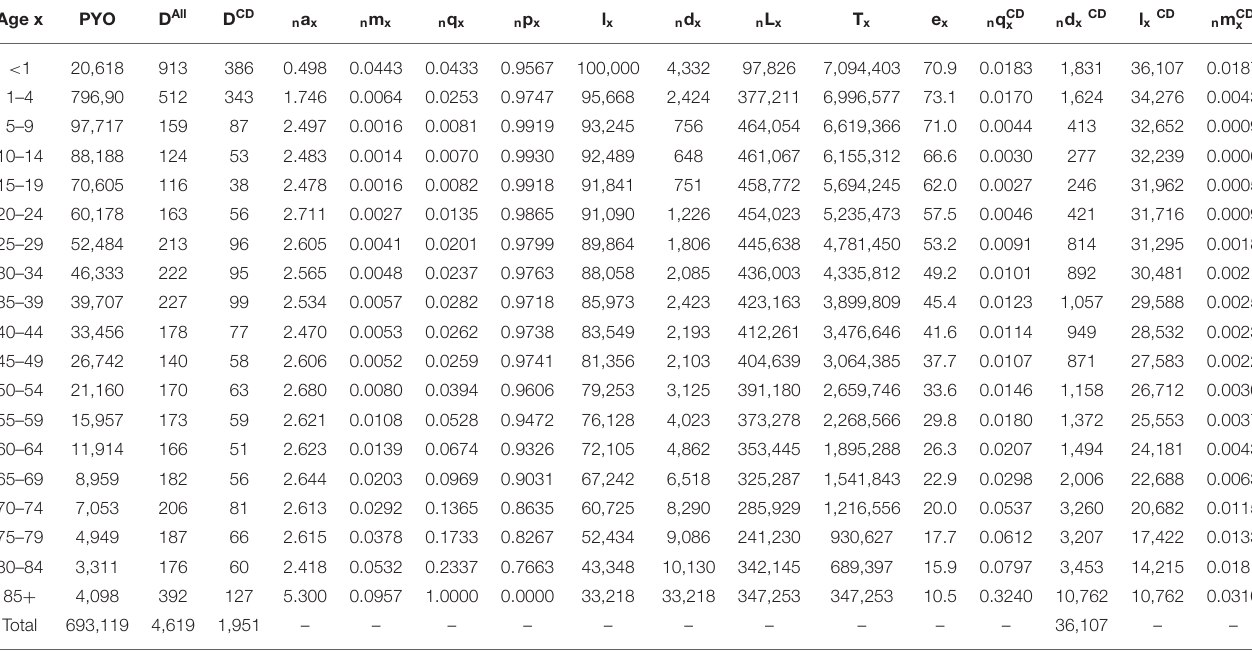
TABLE 4 | A general and multiple-decrement life table for Kintampo HDSS female population (2005–2014). Age